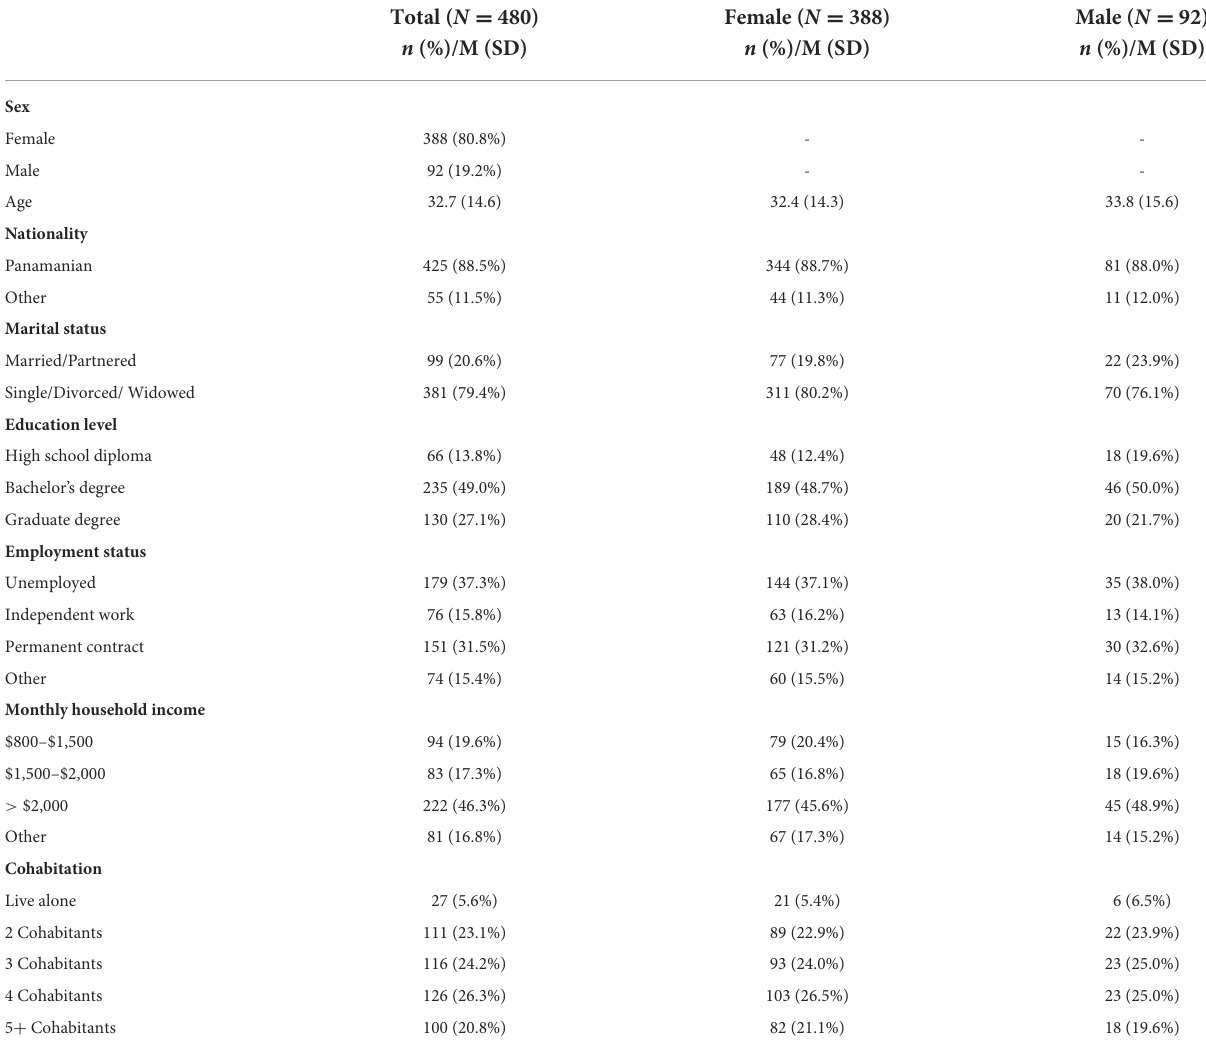
TABLE 1 Sociodemographic